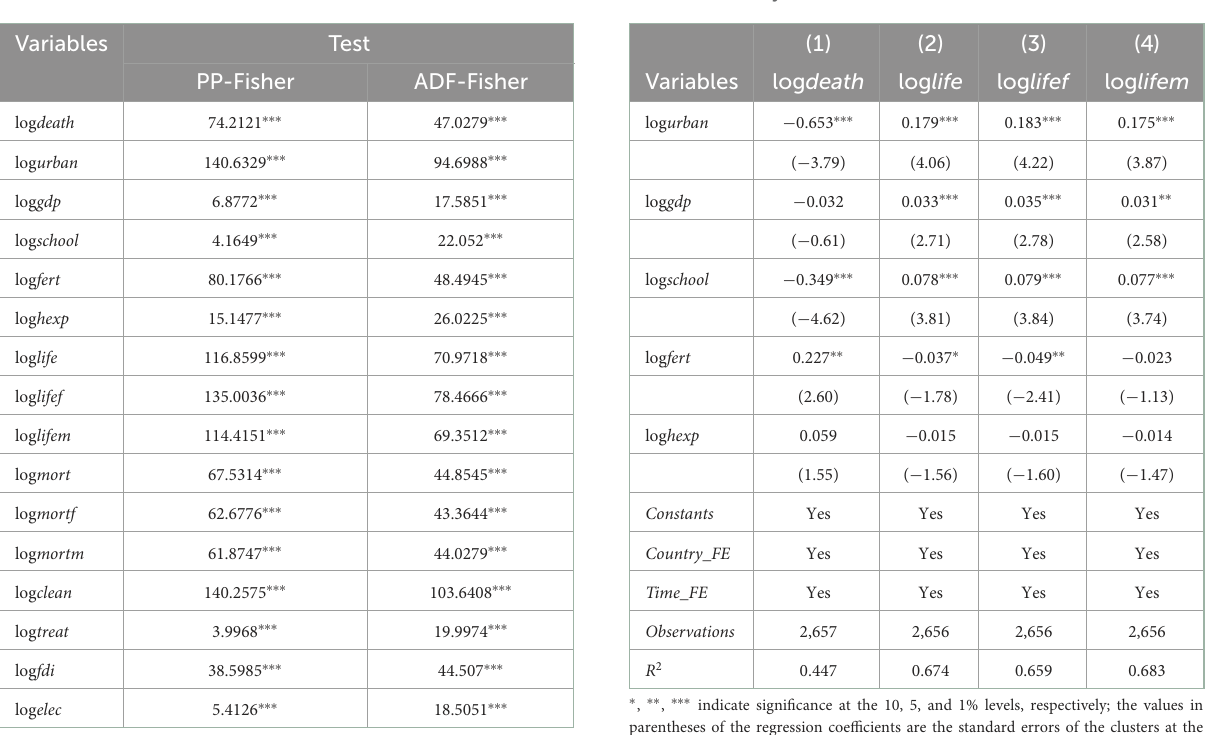
TABLE 2 Panel unit root test results.